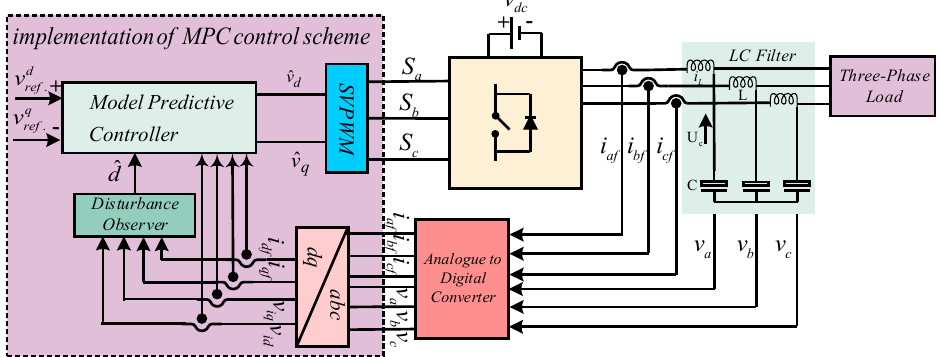
Figure 33. Model Predictive Control topology for VSIs.